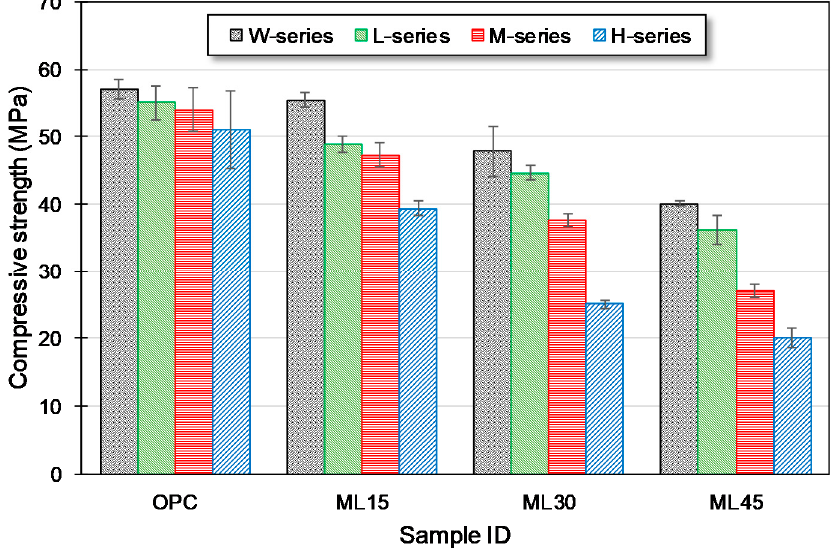
Figure 2. Compressive strength of samples at 28 d of curing.